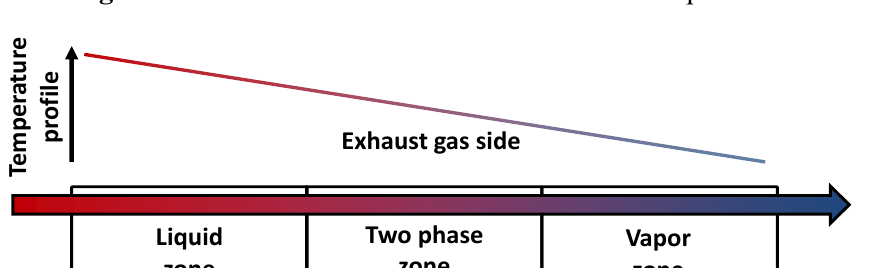
Figure 4. Scheme of a three-zone model for an